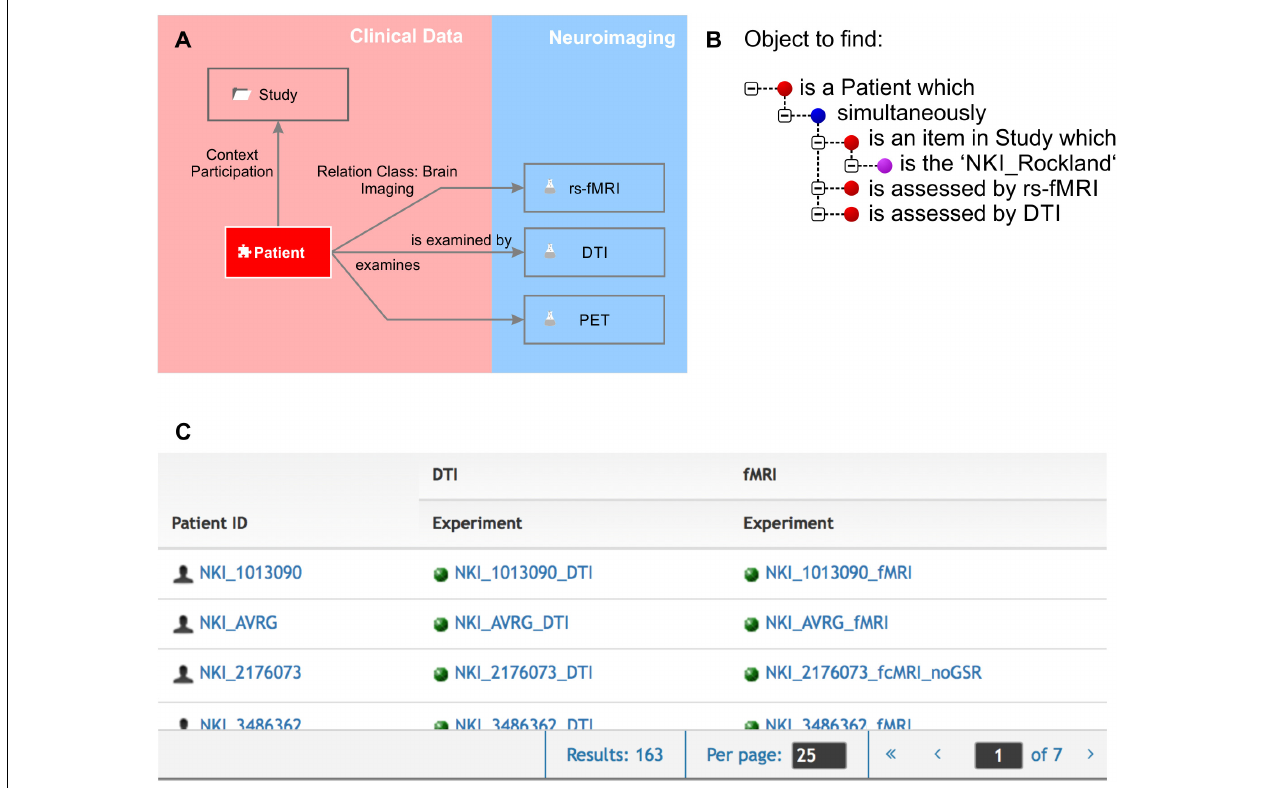
FIGURE 2 | Knowledge model and query language. (A) We zoomed in to the clinical data and the neuroimaging sub-domains. The Relation Class “brain imaging,” indicated by the gray arrows from “patient” to the different imaging experiments, is defined by “is examined by” and “examines” in forward and backward directions, respectively. The “patient” participates in the context “study.” (B) The query language uses the object names and the definitions of the relations. Red bullet points indicate semantic objects, purple bullet points labels and identifiers, and blue bullet points logical operators. (C) The result of the query shown in (B) is a list of patients that fulfill the required conditions that they are part of the NKI Rockland study (Nooner et al., 2012) and have rs-fMRI and DTI experiments